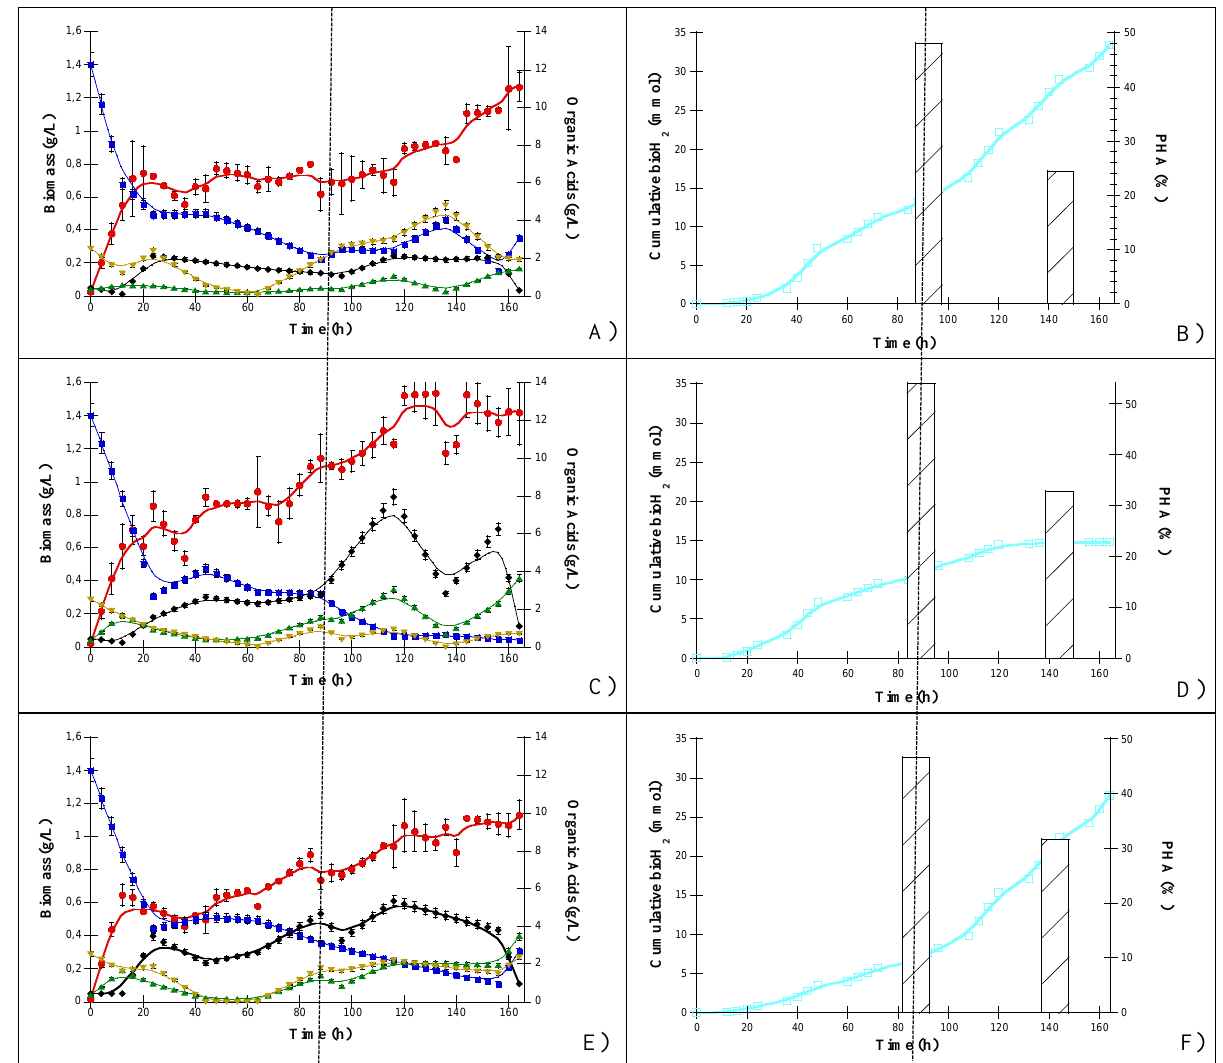
Figure 2. Individual strain patterns of organic acid consumption: HLac ( ), HAc ( ), HPr ( ), HBu ( ), biomass (λ), bioH 2 ( ) and PHA production (bars) obtained by C. pasteurianum in the upper panel ( A , B ), R. palustris in the middle panel ( C , D ), and S. wolfei in the bottom panel ( E , F ).